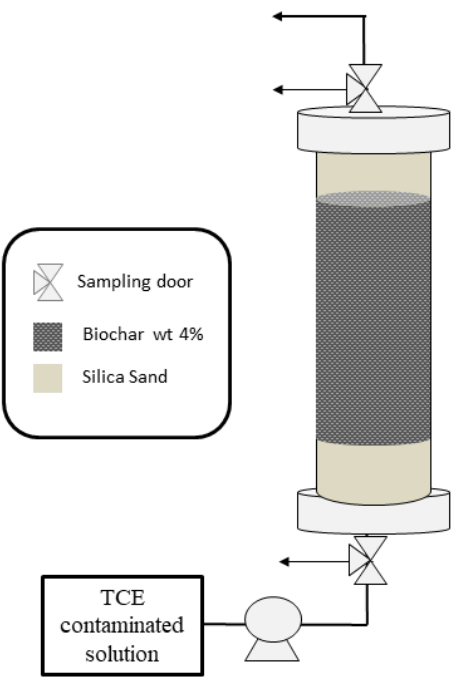
Figure 2. Experimental configuration of the fixed-bed column.